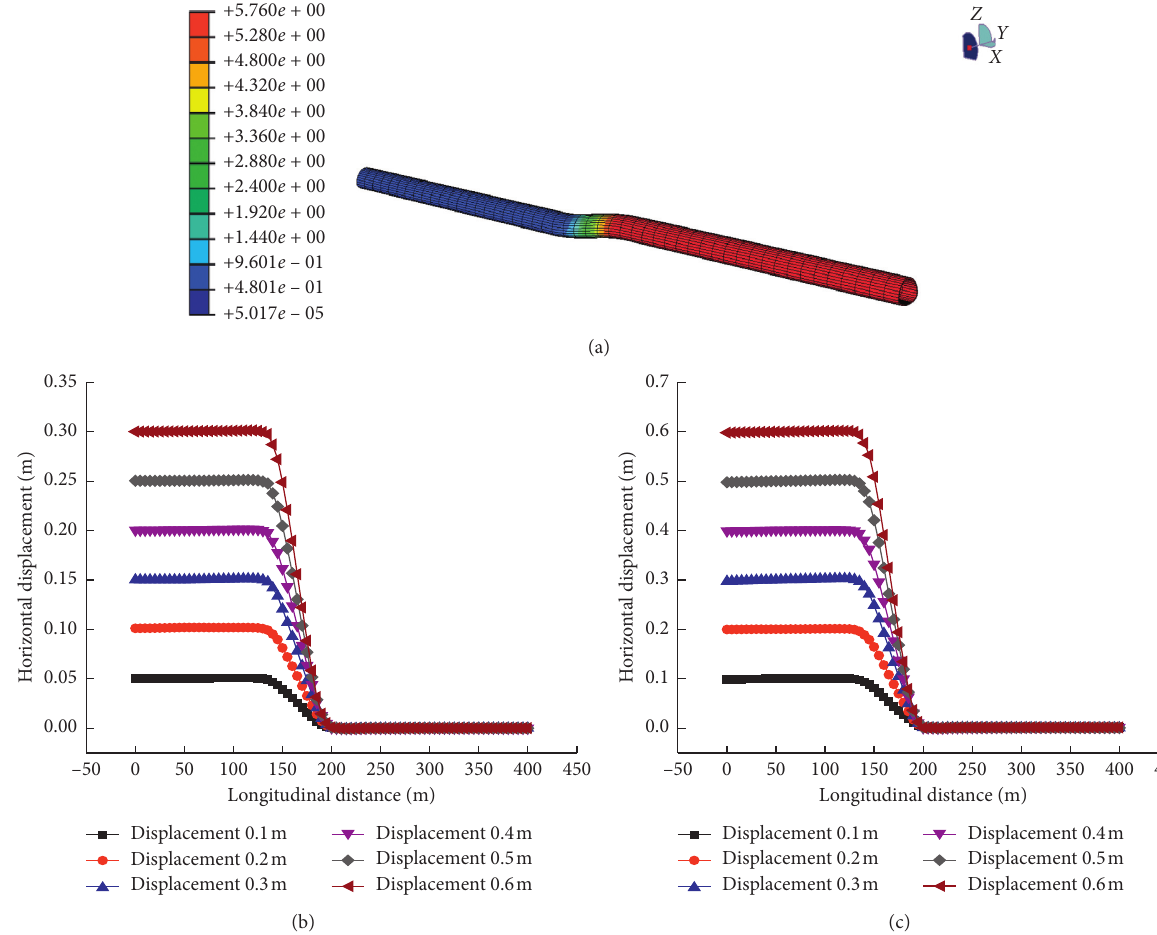
Figure 4: Displacement diagram in different directions under coupling fault. (a) The deformation cloud diagram of lining when the fault displacement is 0.4 m. (b) Y -direction displacement curve of lining with different movement amounts in the coupling ratio of 1 : 2. (c) Z -direction displacement curve of lining with different movement amounts in the coupling ratio of 1 :